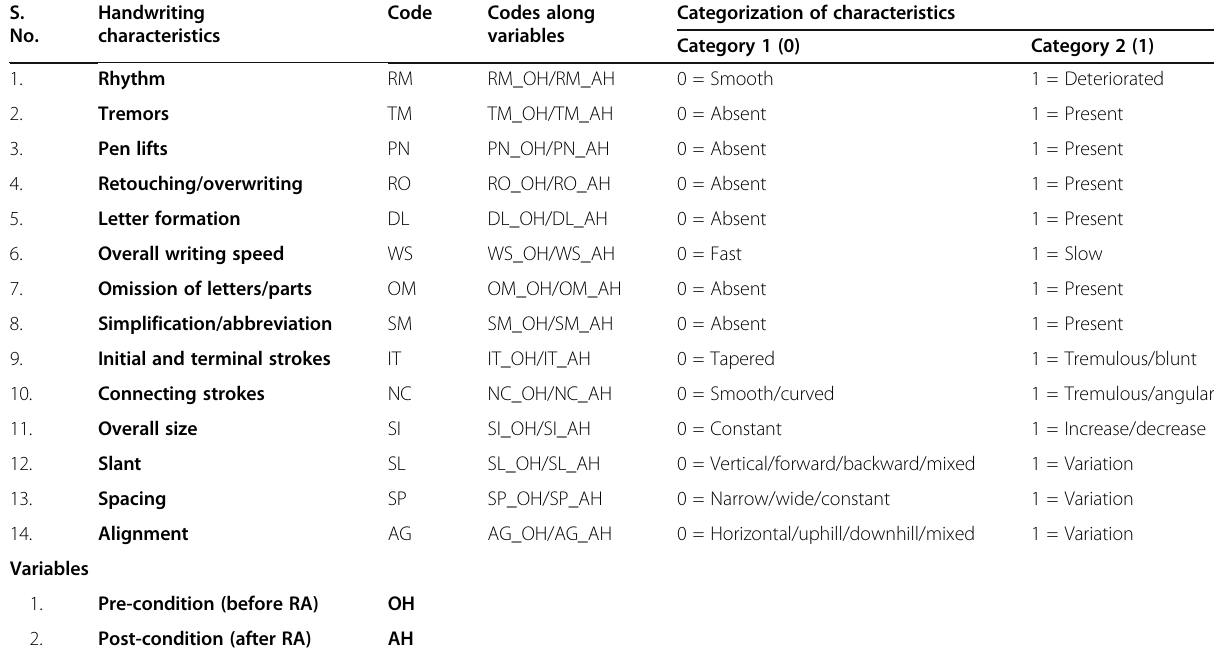
Table 2 Categorization and coding of handwriting characteristics along selected variables S.